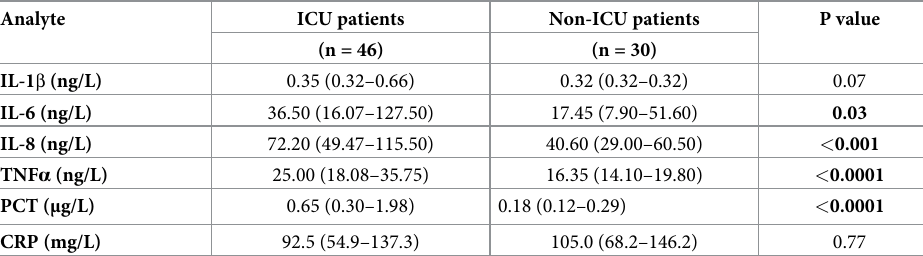
Table 3. Cytokines, PCT and CRP in ICU vs. non-ICU patients with COVID-19.